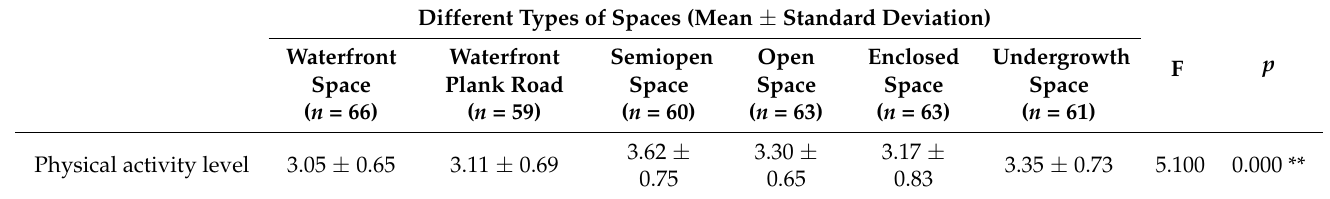
Table 4. Variance results of different types of spaces and children’s physical activity levels.